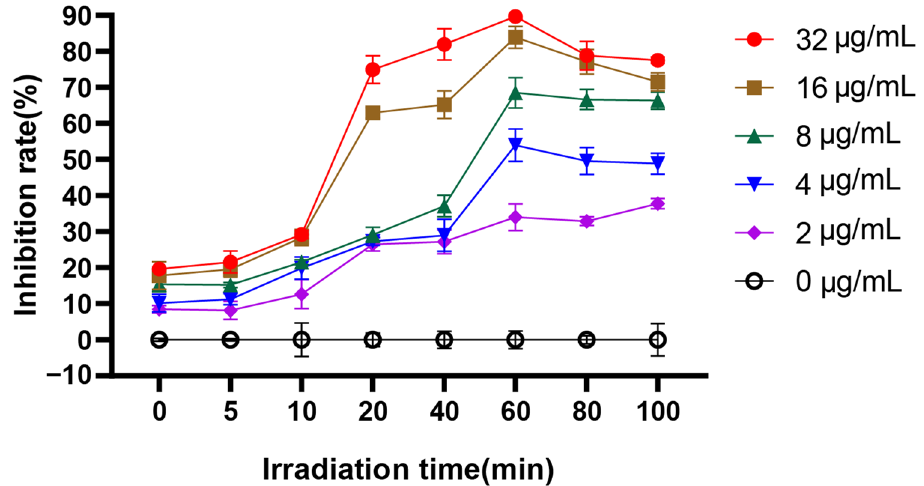
Figure 2. The effect of irradiation time on the inhibition rate of C. albicans biofilm.